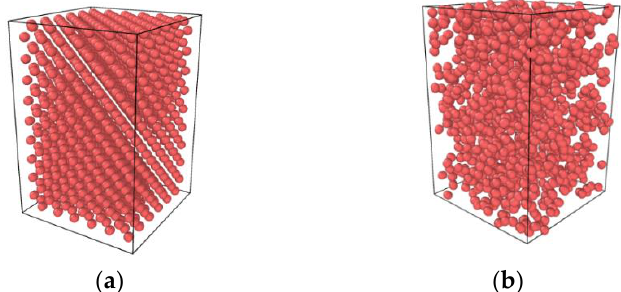
Figure 6 . Nitrogen model made by molecular dynamics: ( a ) initial nitrogen distribution; ( b ) well- proportioned nitrogen.